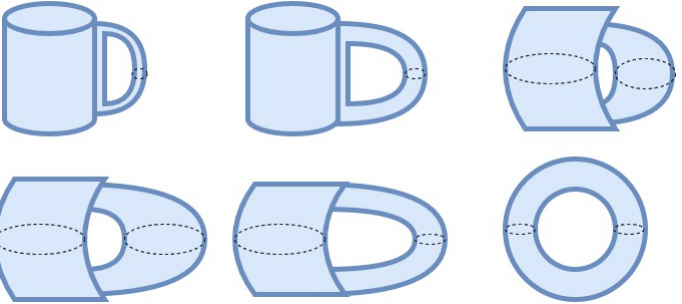
Figure 3. Example of homeomorphism: a mug is topologically equivalent to a